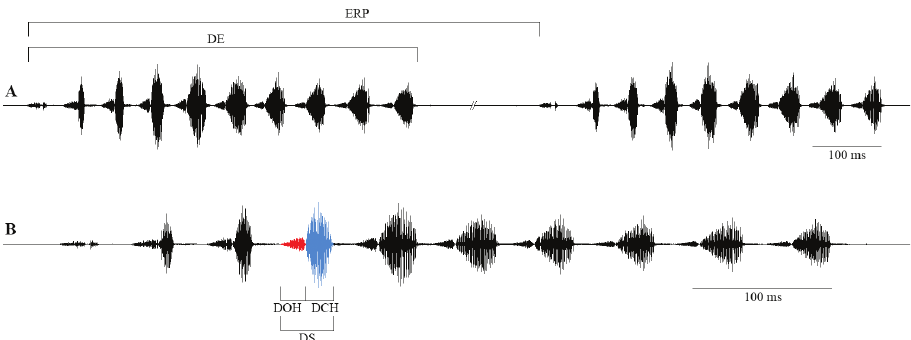
Figure 1. Studied male calling song oscillographic characters in Parapholidoptera castaneoviridis : A se- quence of two echemes B detailed echeme (red – opening hemisyllable, blue – closing hemisyllable). Abbreviations: ERP – echeme repetition period; DE – duration of an echeme; DOH – duration of an opening hemisyllable; DCH – duration of a closing hemisyllable; DS – duration of a